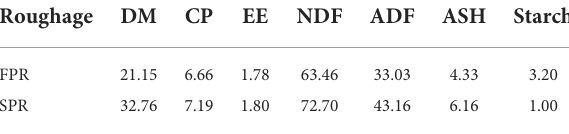
TABLE 2 Nutritional compositions of FPR and SPR (%, DM